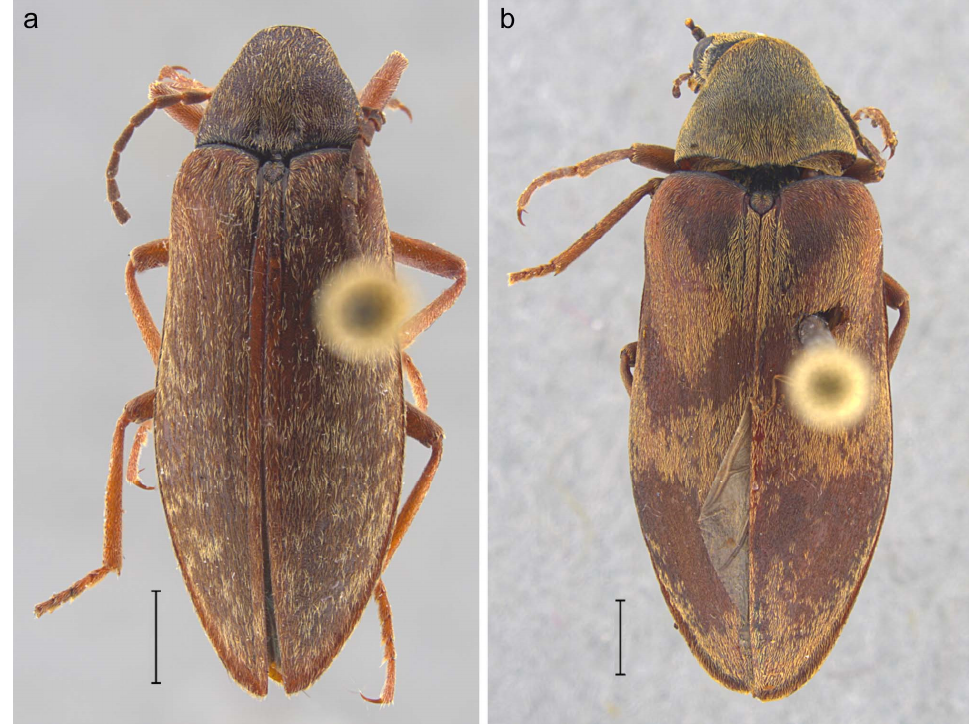
Figure 2. Araeopidius monachus (LeConte, 1874), dorsal habitus. ( a ) M1 color morph; ( b ) M2 color morph. Scale bars = 1.0 mm.